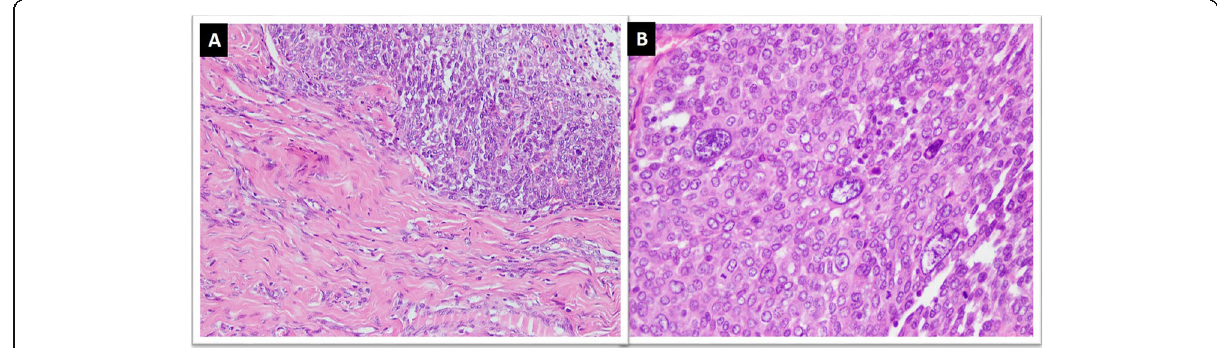
Fig. 5 Dedifferentiated SFT; a . Abrupt transition of conventional SFT areas with high grade sarcomatous areas with, b . marked nuclear pleomorphism and increased